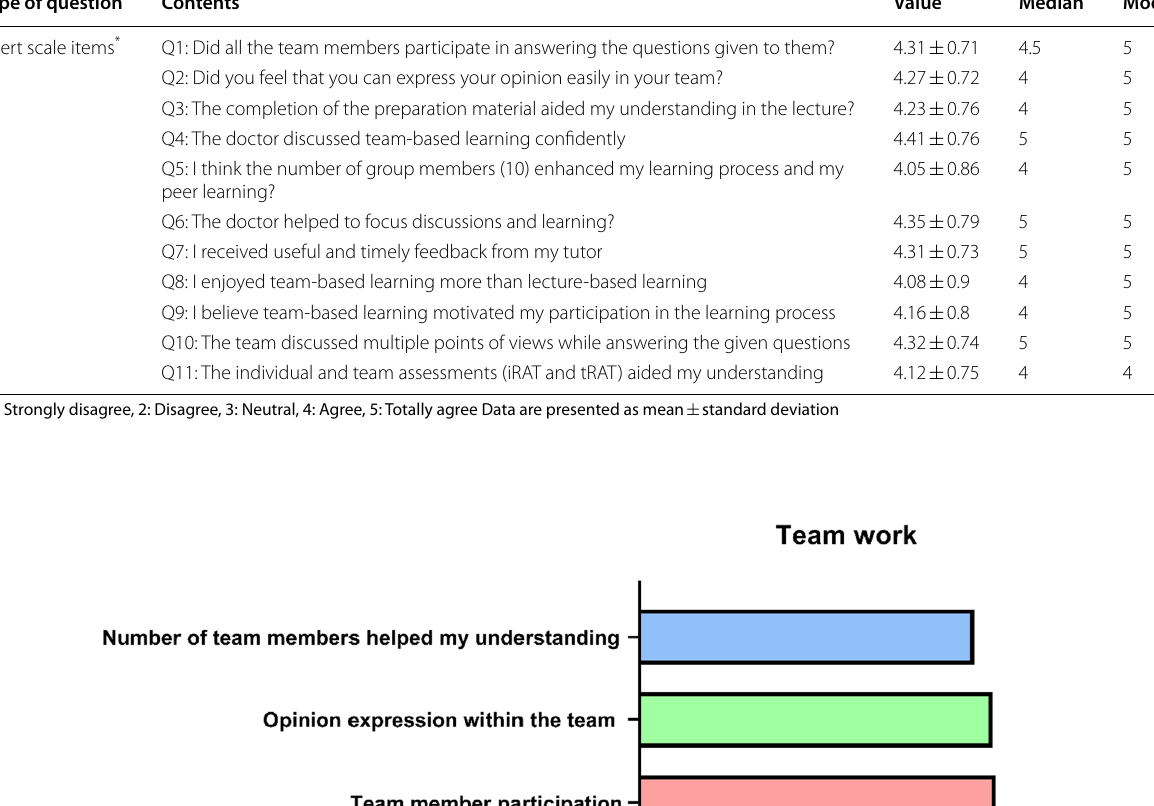
Fig. 3 The students’ opinions about the learning process in teams. Data are presented as mean